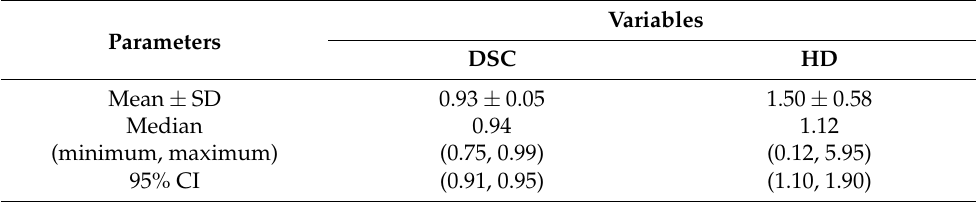
Table 3. Analysis of DSC and HD variables of 40 patients.